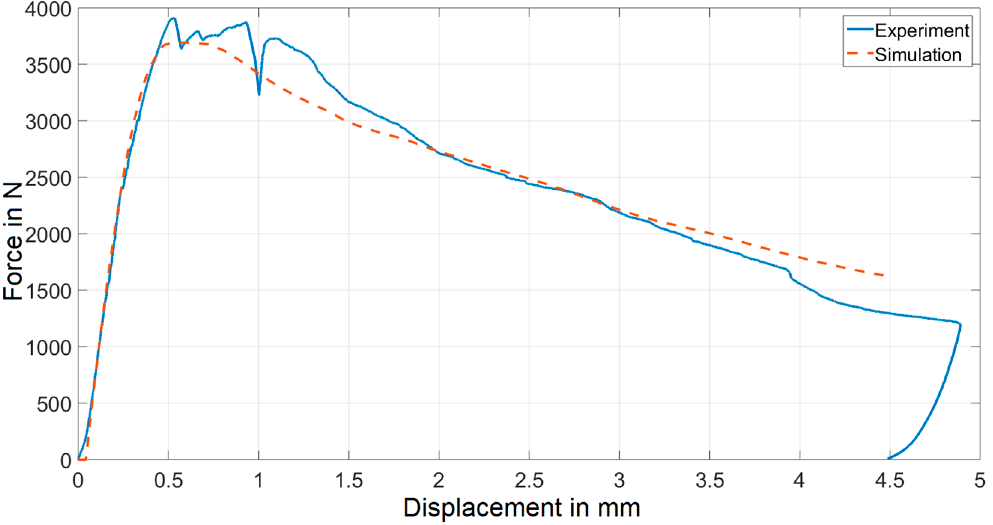
Figure 8. Comparison of experimental and simulated force-displacement curves for the second experiment.